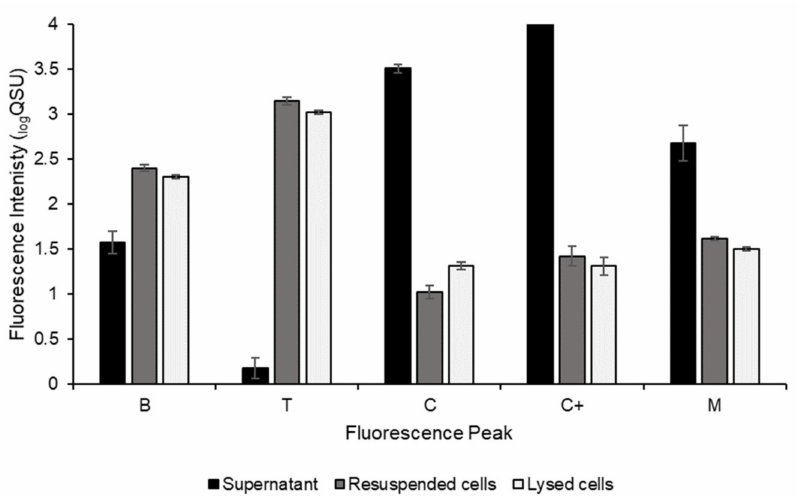
Figure 1. Apportionment of observed fluorescent organic matter produced by an environmental microbial community, derived from an environmental freshwater sample, cultured for 24 h at 30 ◦ C. Fluorescence intensity (QSU, 1 QSU = 1 µ g L − 1 quinine sulphate) is shown for Peaks B, T, M, C and C+ ( n = 3 ±